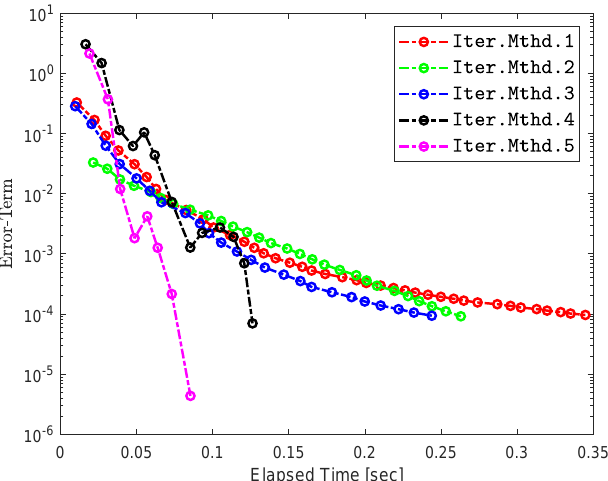
Figure 2. All techniques are computationally examined while s 0 = ( 1,1,1,1,1 ) T .